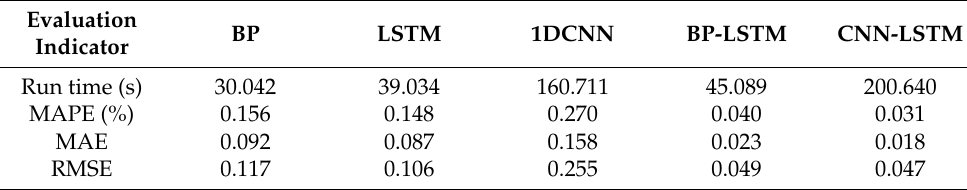
Table 5. Experimental evaluation